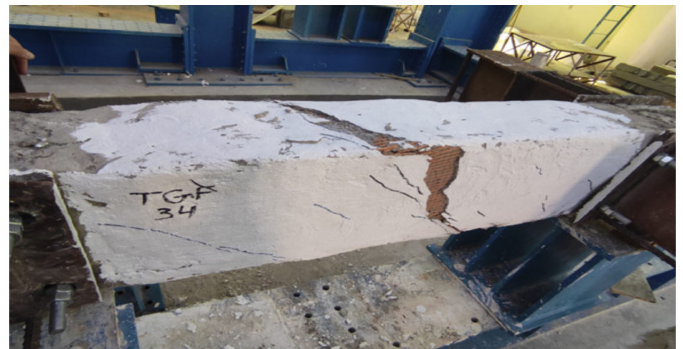
Figure 17. Final crack of beam B2-SS.